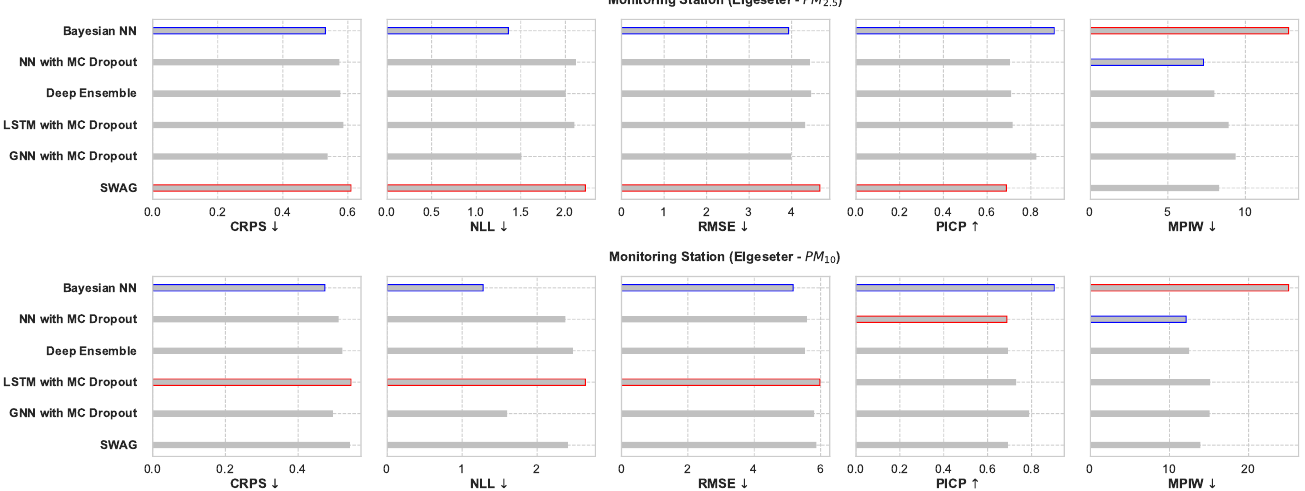
Figure 25. Comparison of empirical performance of the selected probabilistic models in the PM-value regression task. The comparison is according to five performance metrics (left to right): CRPS, NLL, RMSE, PICP, and MPIW. Blue highlights the best performance, while red highlights the worst performance. The arrows alongside the metrics indicate which direction is better for that specific